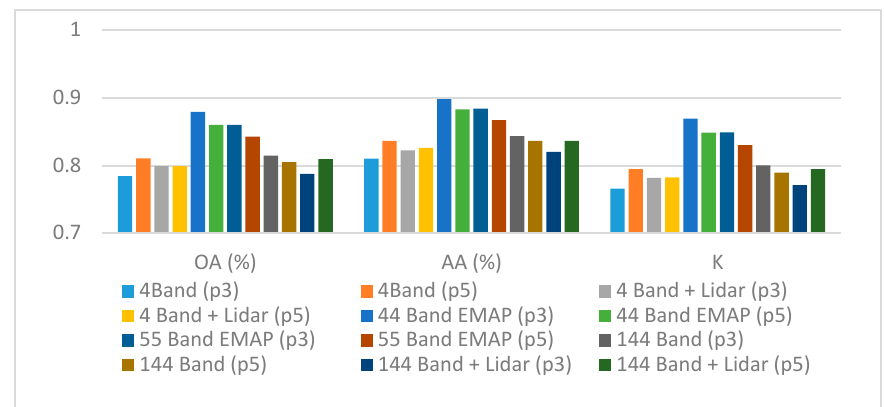
Figure 4. Performance metrics for the investigated band combinations with our customized CNN model.